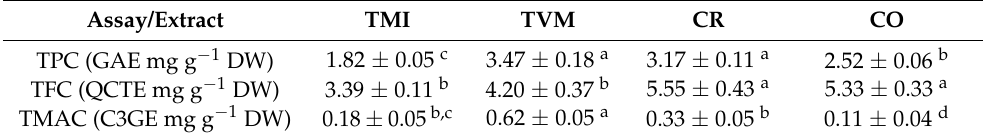
Table 2. Chemical composition of the tamarillo extracts of the present study (TPC, TFC, and